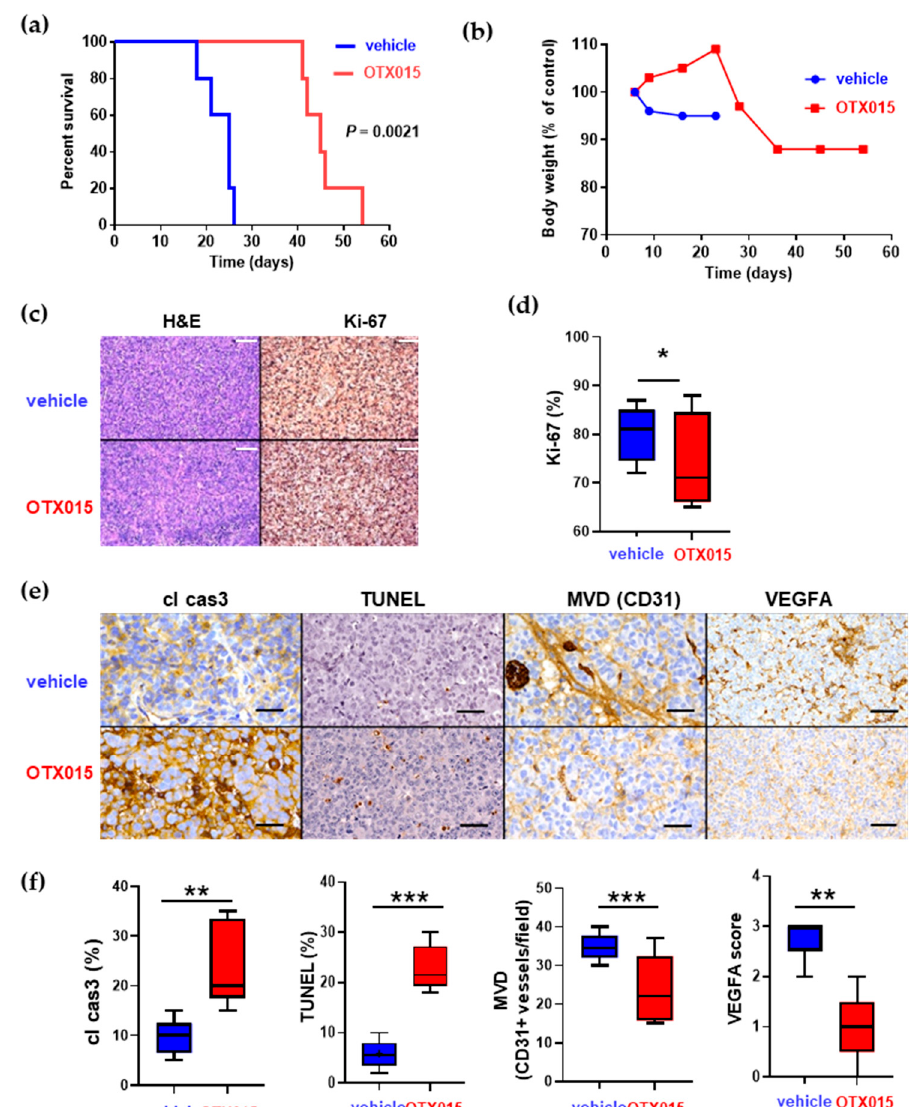
Figure 5. In vivo effects of OTX015 in an EPP(#1)-MI orthotopic EPN model. ( a ) Survival analysis of the mice bearing intracranial EPP(#1)-MI tumors. Animals were treated with a vehicle or OTX015 (50 mg/kg/BID, n = 5 mice/group or more). On the appearance of brain tumor symptoms, animals were sacrificed. Survival was examined using the Kaplan–Meier method. ( b ) Effects of the treatment regimen shown in panel ( a ) on the body weight changes of animals bearing EPP(#1)-MI tumors. ( c ) Representative images of EPP(#1)-MI tumor sections stained with hematoxylin/eosin and immunohistochemical staining for proliferating cells (Ki-67), apoptotic cells (cl cas3) and VEGFA. Scale bars, 100 µ m. ( d ) Quantitation of staining shown in ( c ) was calculated from three parallel slides (five random fields per each slide) and was expressed as the average percent positive. ( e ) Intracranial EPP(#1)-MI tumor sections from mice treated with a vehicle or OTX015 were stained to detect apopto- sis (cl cas3 and TUNEL) and angiogenesis (CD31 and VEGFA). Scale bars, 70 µ M. ( f ) Quantitation of staining shown in ( e ) was calculated as the ratio of cl cas3- or TUNEL-positive cells to total cells. The number of CD31-positive vessels/field of tumor sections was used to indicate microvessel density (MVD). The VEGFA score was calculated as described in Materials and Methods. Student’s t -test was used for statistical significance. * p = 0.05; ** p < 0.02; *** p < 0.01, significantly different from the sections of vehicle-treated animals. cl cas3 = cleaved caspase